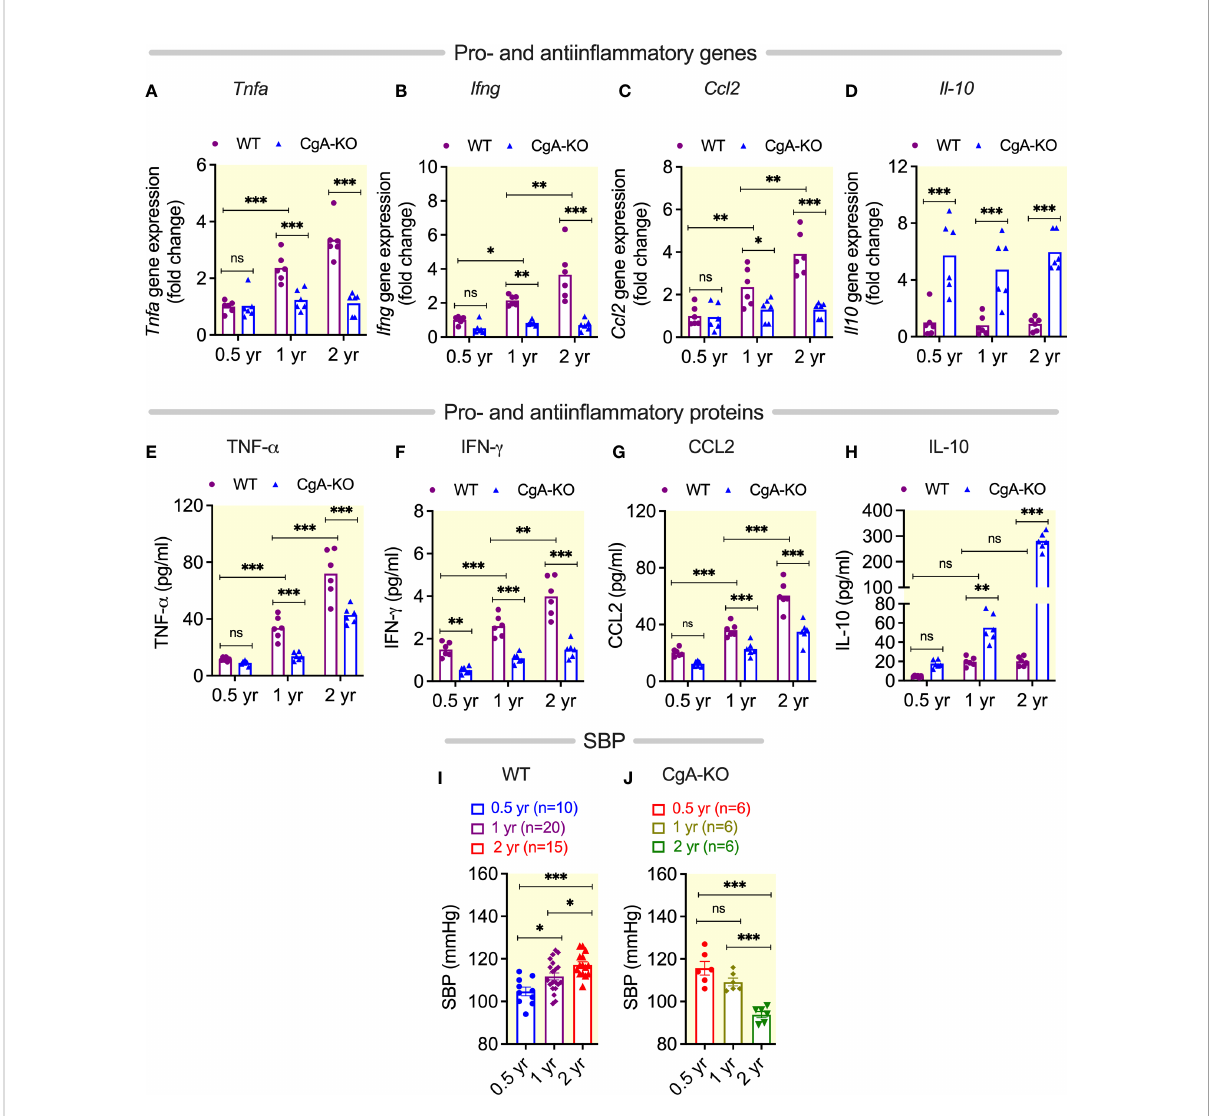
FIGURE 2 Age-associated In fl ammation and blood pressure. (A – D) Steady-state mRNA levels of hepatic pro-in fl ammatory genes (A) Tnfa , (B) Ifng , and (C) Ccl2 , as well as anti-in fl ammatory gene (D) Il10 . (E – H) Plasma levels of pro-in fl ammatory proteins (E) TNF- a , (F) IFN- g , and (G) CCL2, as well as anti-in fl ammatory protein (H) IL10. Blood pressure in (I) WT and (J) CgA-KO mice. *P <0.05; **P <0.01; ***P